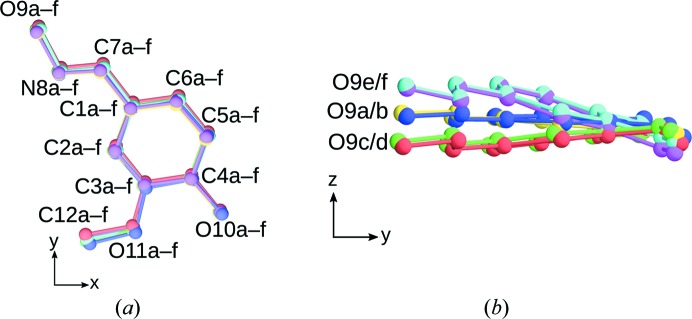
An overlay of the six molecules in the LT phase when mapped onto each other by a symmetry operation of the HT phase projected (a) onto (001) and (b) down [010]HT. Molecule colours are as in Fig. 3 ▸.